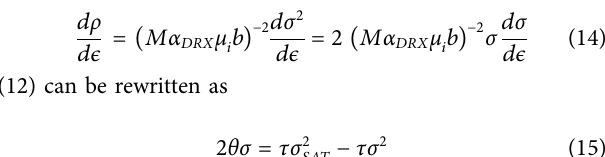
recrystallization and dynamic transformation for all temperatures and strain rate 0.01 s − 1 .